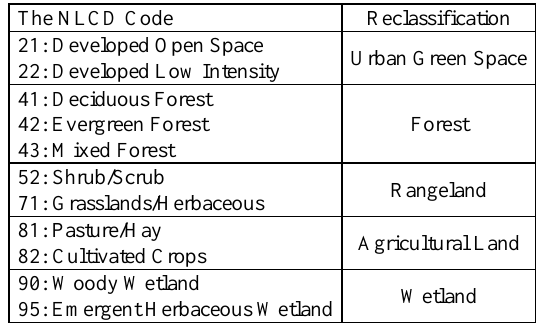
Table 1. NLCD Green space